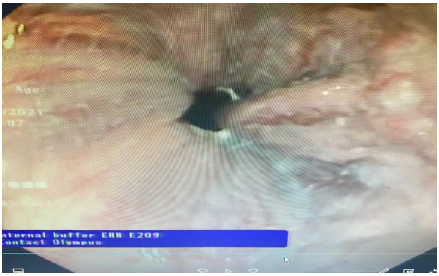
Figure 2 . The evidence of grade I varices as seen on the endoscopy